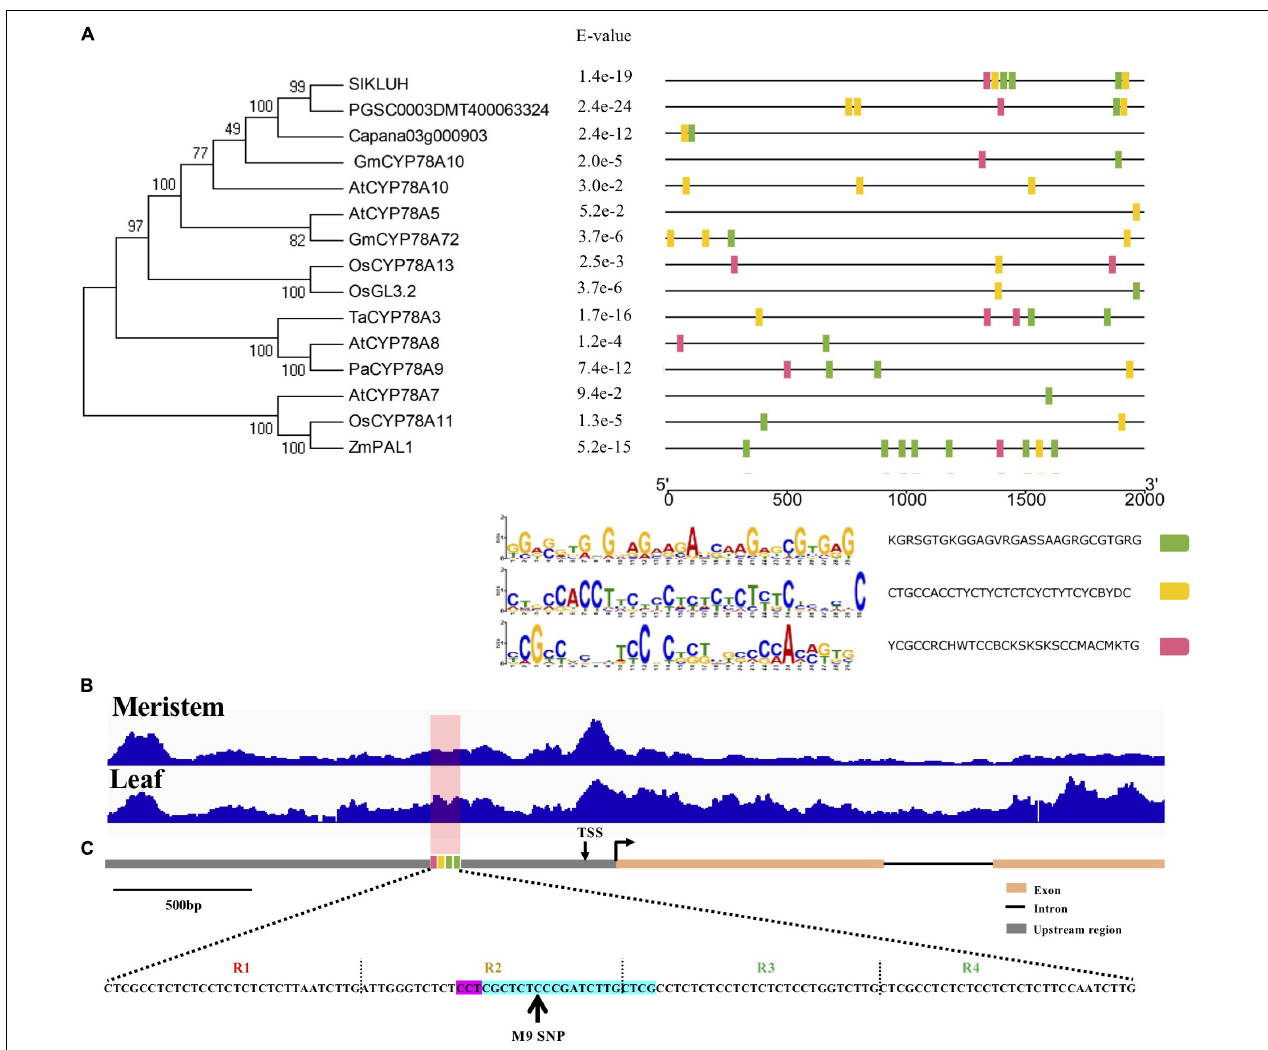
FIGURE 1 | Identification of putative cis -regulatory element in SlKLUH promoter using homology-based prediction and ATAC-seq. (A) Conserved motif analysis in the promoters of CYP78A members. The unrooted phylogenetic tree was depicted by the MEGA program with the neighbor-joining (NJ) method using full protein sequences of 15 CYP78As from tomato ( Sl ), pepper ( Capana03g000903 ), potato ( PGSC0003DMT400063324 ), Arabidopsis ( At ), rice ( Os ), wheat ( Ta ), soybean ( Gm ), maize ( Zm ), and sweet cherry ( Pa ). To identify the conserved motifs, the 2-kb upstream region of the start codon of the KLUH s was analyzed in MEME with the following parameters: “nmotifs 3, minw 6, maxw 30”; (B) ATAC-seq indicated that the target region was located in open chromatin. The data were visualized by the Integrative Genomics Viewer. The peaks at the target region were indicated by red shading; (C) A schematic map of the gRNA-targeted site. The protospacer adjacent motif (PAM) site and gRNA were highlighted in pink and cyan, respectively. The four tandem repeats in promoter were indicated by R1, R2, R3, and R4. TSS, transcription start